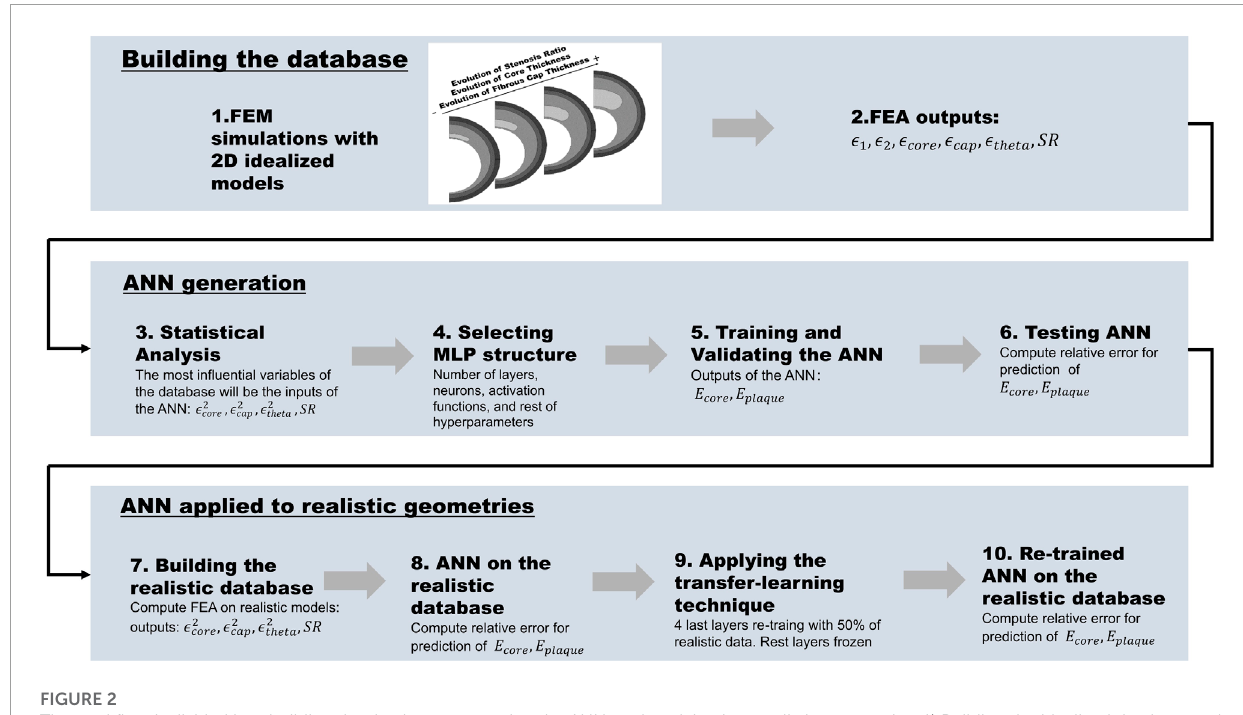
FIGURE 2 The workflow is divided into building the database, generating the ANN, and applying it to realistic geometries: 1) Building the idealized database and performing the FEA simulations; 2) Selecting the outputs of the FEA ( ϵ 1 , ϵ 2 , ϵ core , ϵ plaque , ϵ theta , and SR ); 3) Statistical analysis of the FEA output variables and selection of the inputs of the ANN ( ϵ 2 core , ϵ 2 , ϵ 2 , and SR ); 4) Selecting MLP structure; 5) Training and validating the ANN; 6) Testing the ANN by plaque theta computing the relative error in the prediction of E core and E plaque ; 7) Building the realistic database; 8) Application of the ANN to the realistic database; 9) Application of transfer-learning technique; 10) Application of the transfer-learned ANN to the realistic database and computation of the relative errors.